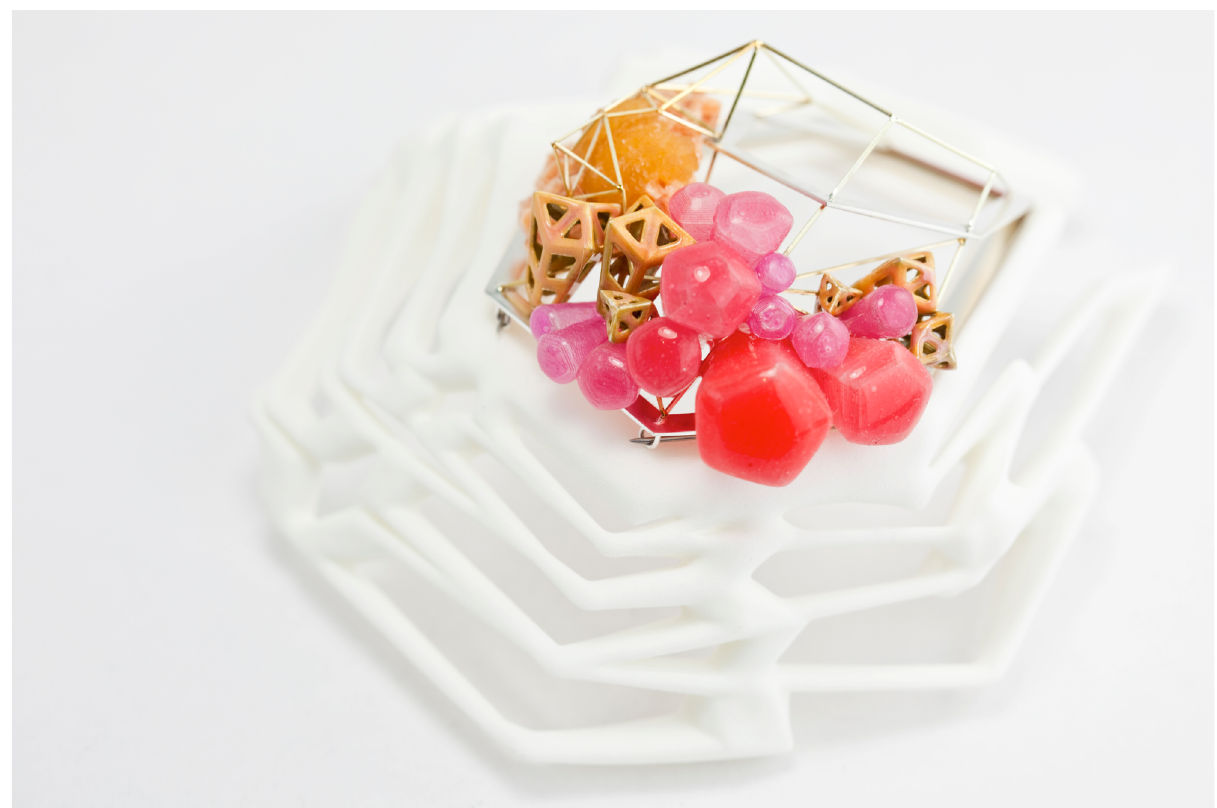
Figure 8 | Xylaria Brooch in its unchanged state on custom made stand, Katharina Vones (2013).